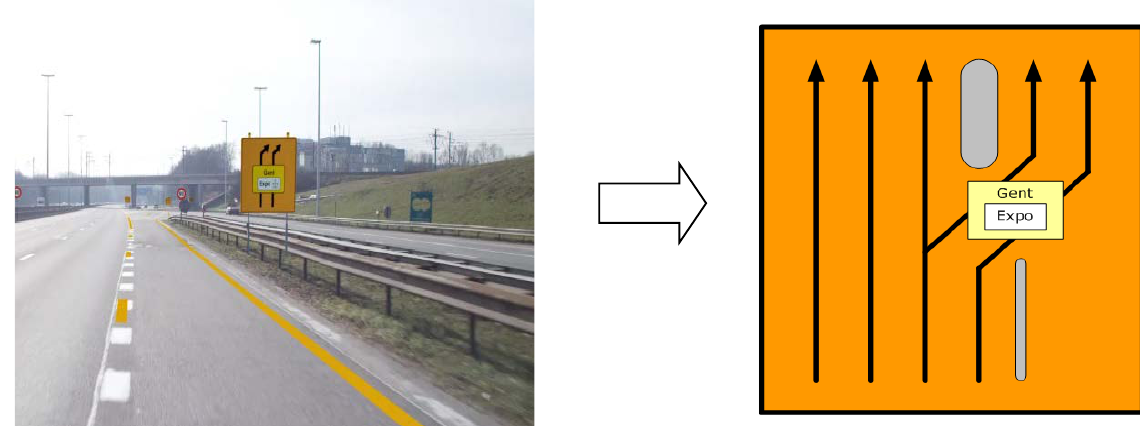
Figure 10. Example of context-dependent traffic sign